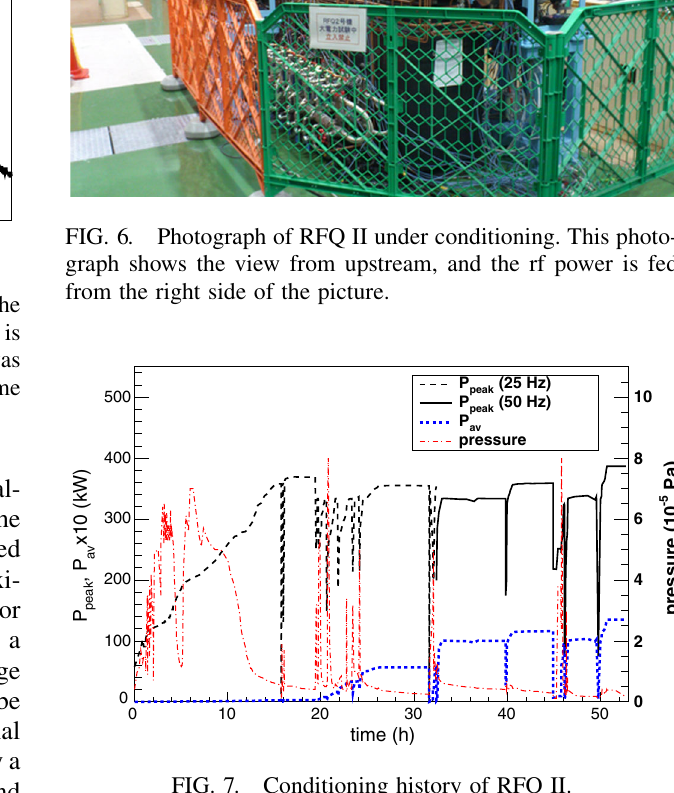
FIG. 7. Conditioning history of RFQ II.